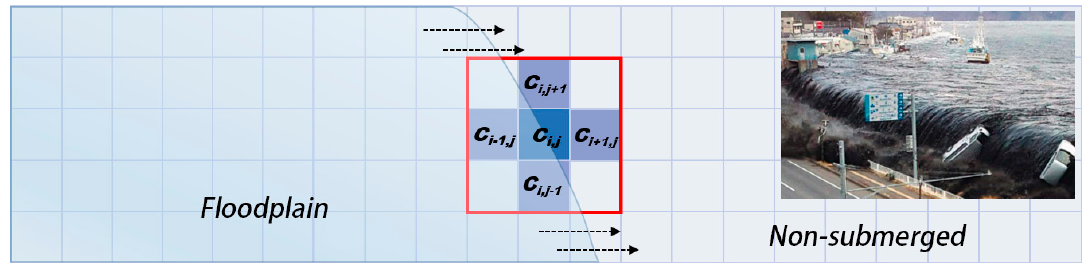
Figure 4. Von-Neumann-type neighborhood.